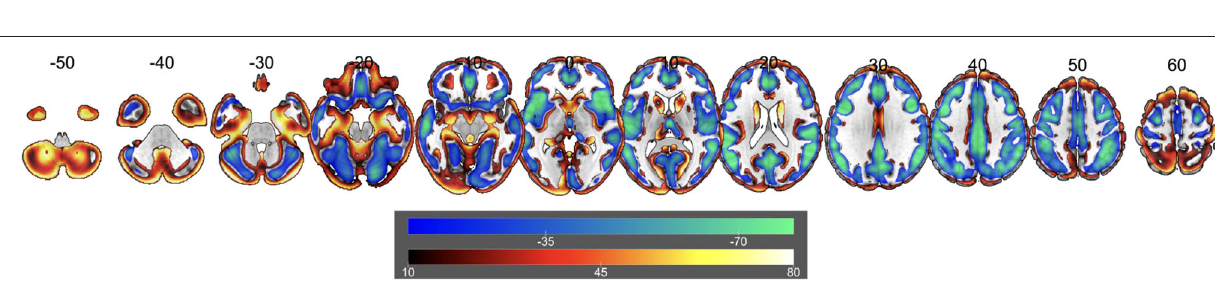
FIGURE 4 | Trade-off between MAE (row 1) and ADC (row 2) as a function of the hyperparameter ρ that represents the correlation bound in our models. The shaded area around the lines represents standard deviation. Increasing ρ leads to a lower MAE but this comes at the expense of ADC increasing in magnitude. MAE and ADC change in a similar way on training and test sets, suggesting that the training set is a good proxy for test set performance.